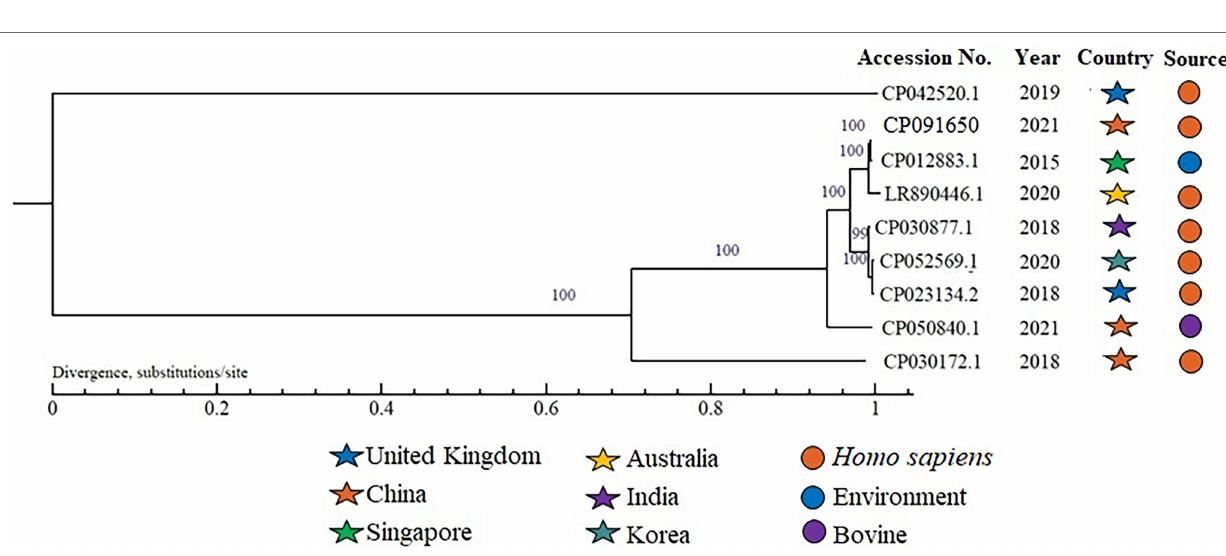
FIGURE 4 | A phylogenetic tree of nine K54-hvKP isolates. The numbers on the branch indicate the branch reliability. The closer the value is to 100, the higher the reliability is. The branch length represents the evolutionary distance, which is calculated by the average number of substitutions per